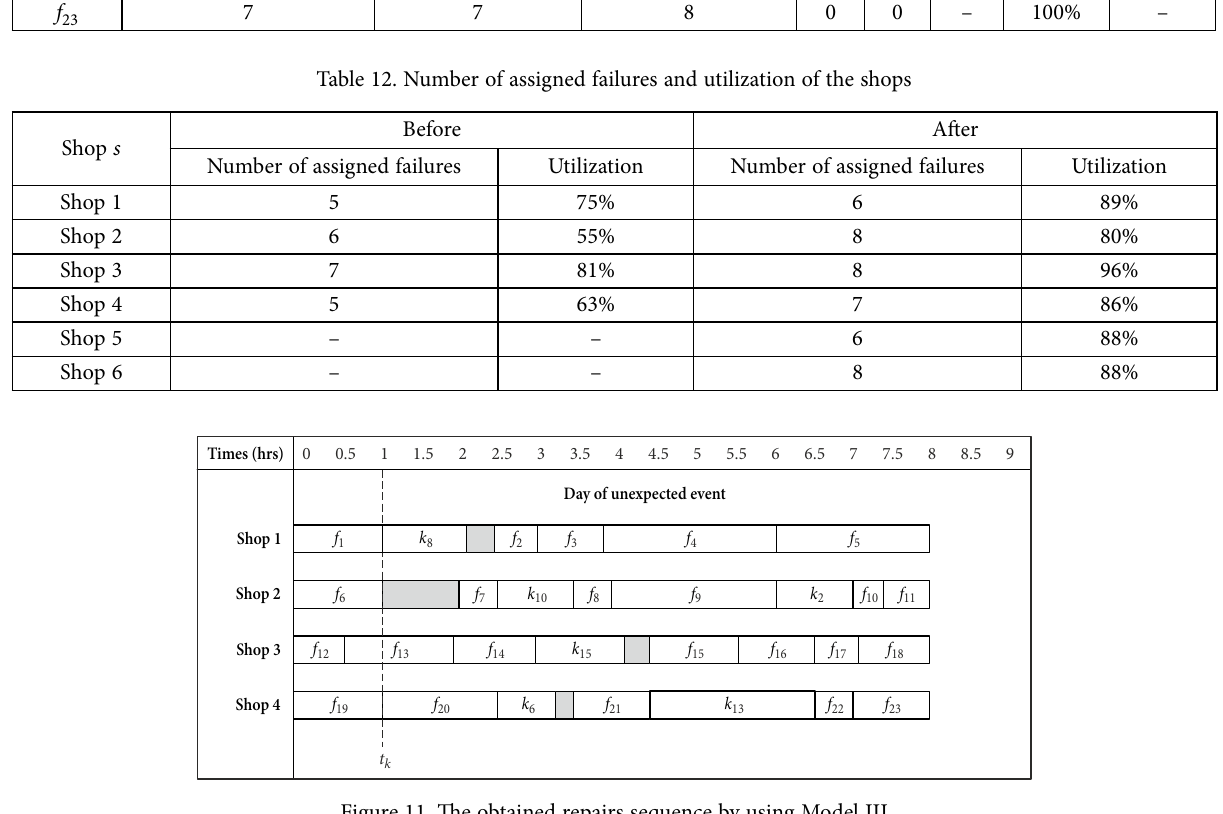
Figure 11. The obtained repairs sequence by using Model III